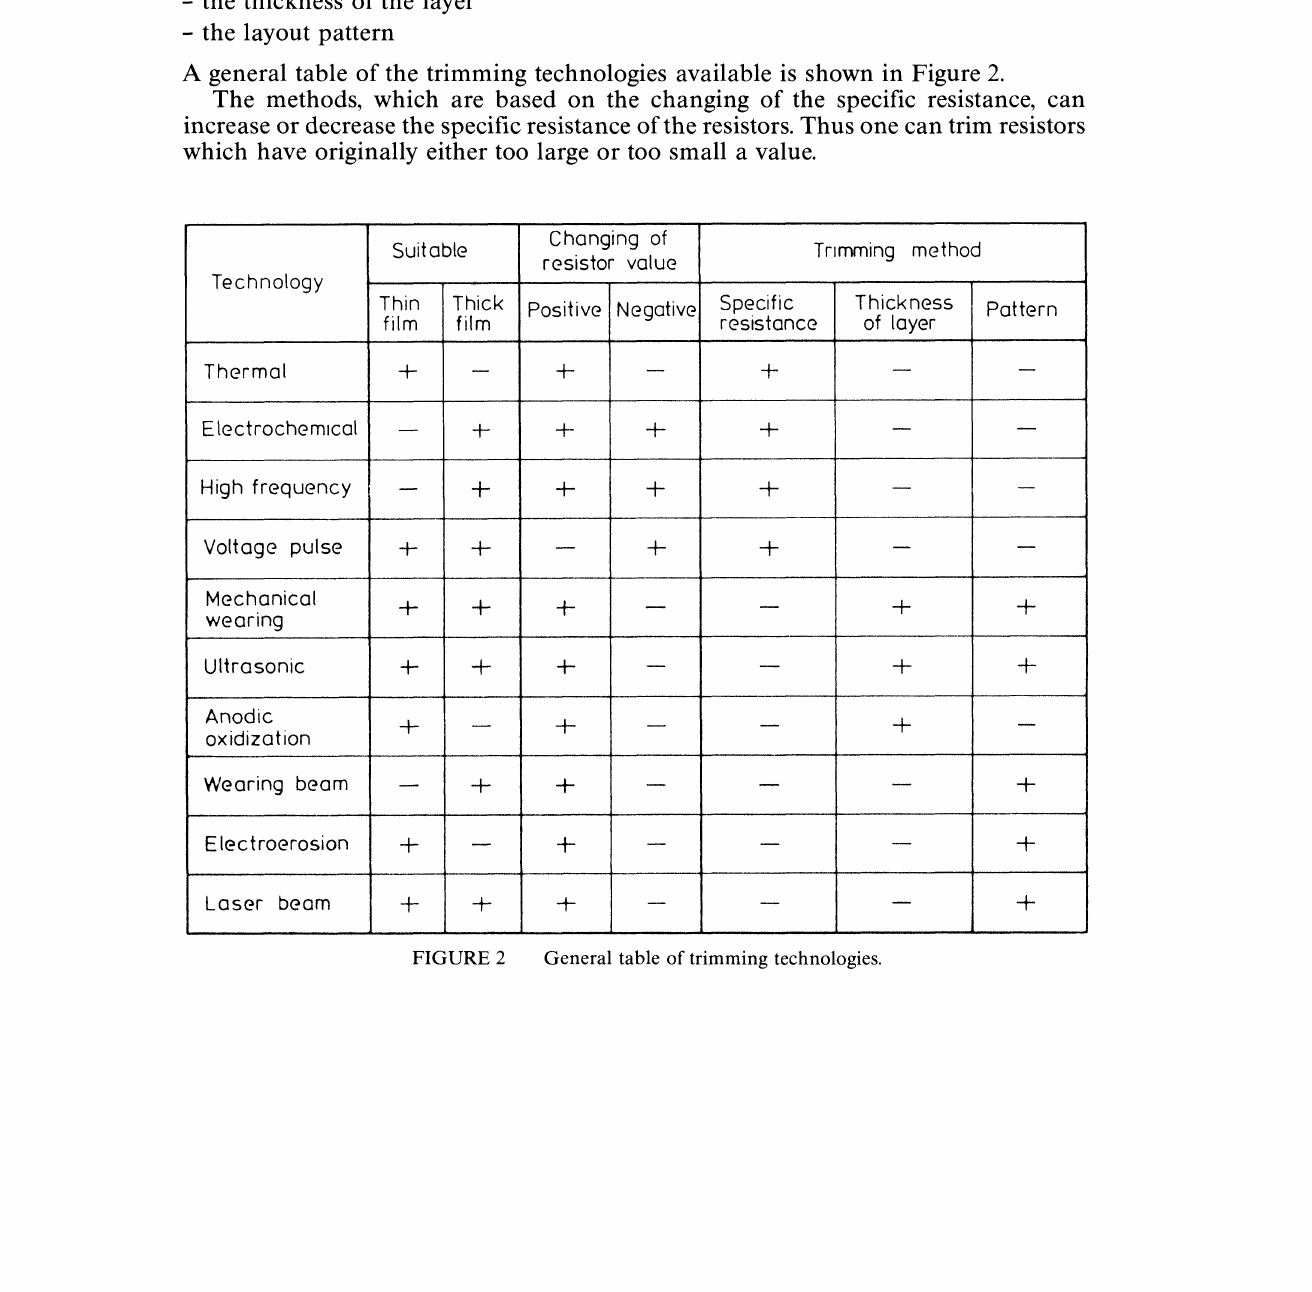
General table of trimming